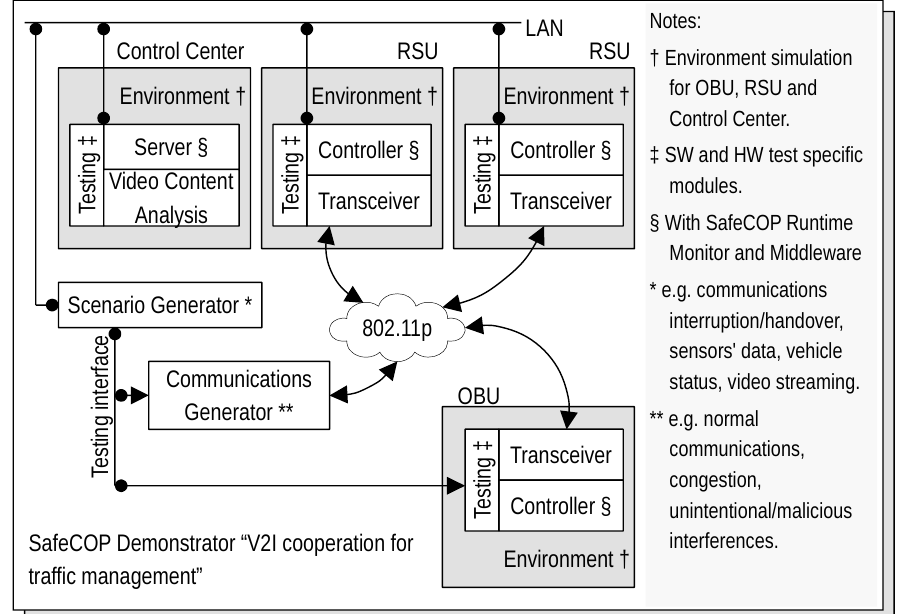
Figure 6. System architecture for the traffic management application through V2I